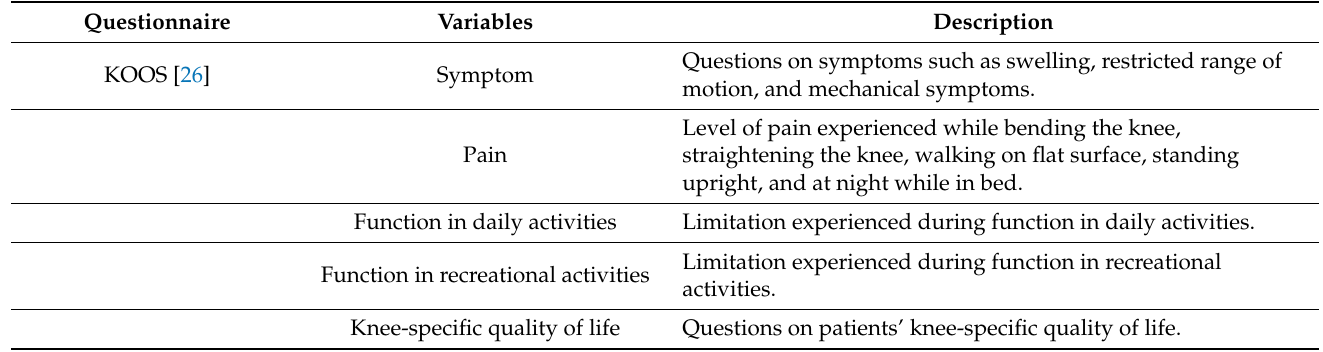
Table 1. Operational definitions used in the